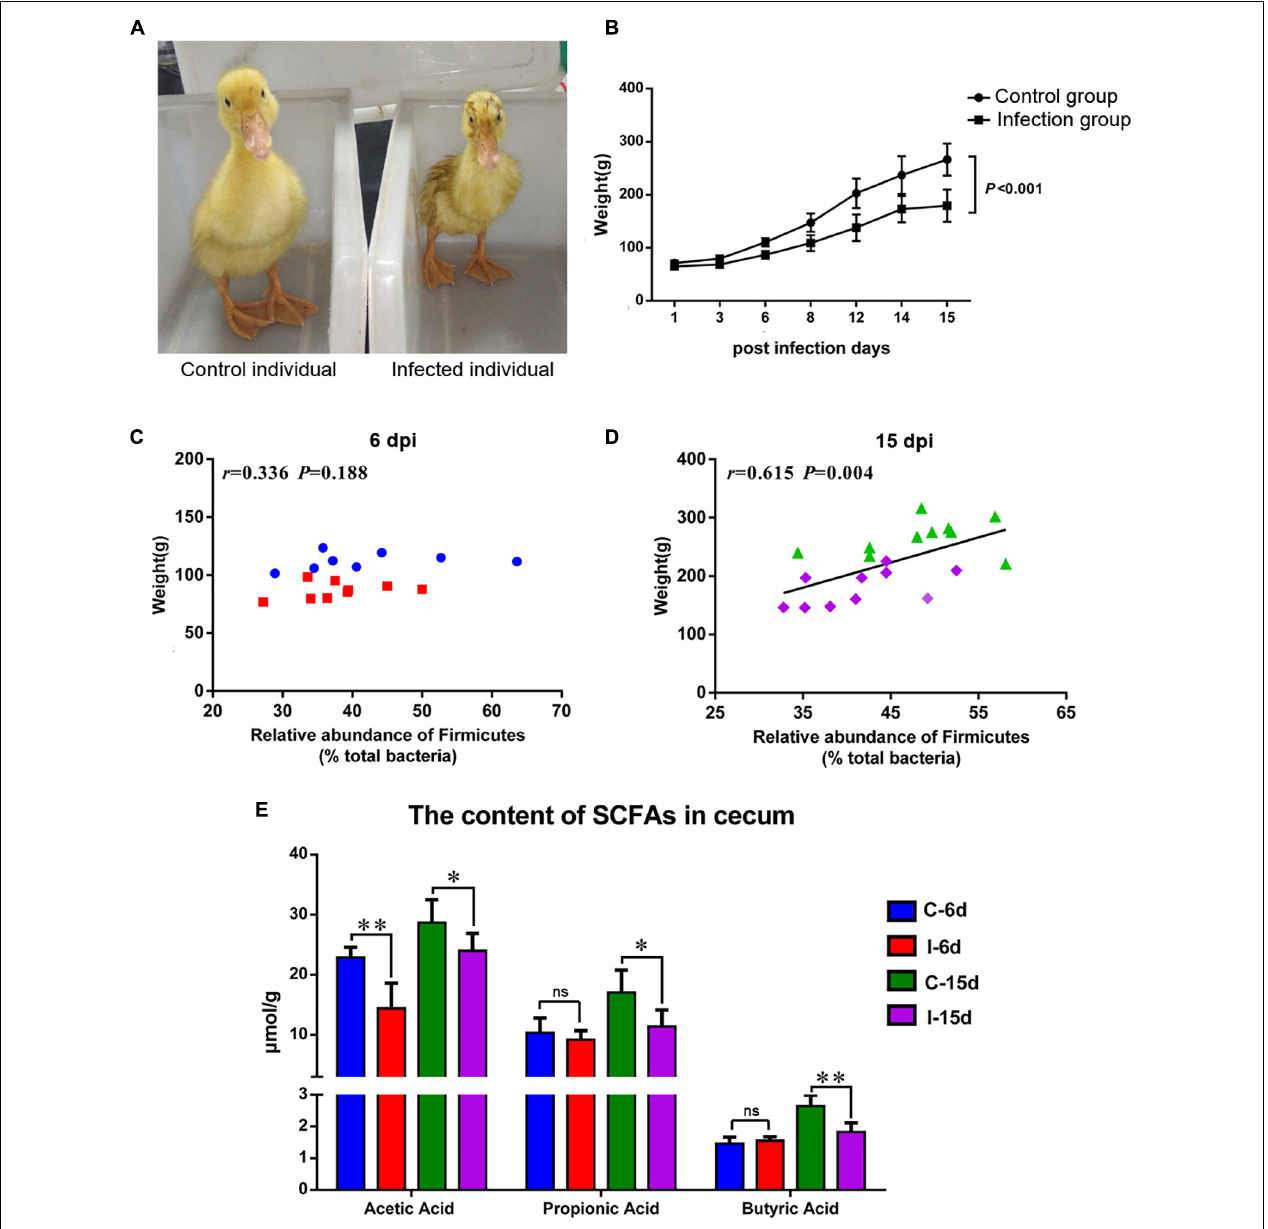
FIGURE 6 | (A) Individual comparison between control duck and infected duck. (B) Body weight of control group and D-GVP infection group ( P < 0.01 by two-tailed Student’s t -test). (C,D) Association between the relative abundance of Firmicutes and body weight of control samples and D-GPV infected samples at 6 dpi and 15 dpi, respectively. Statistical analysis was performed using the Spearman t -test. (E) Effect of D-GPV infection on SCFAs content in caecum. ∗ P < 0.05, ∗∗ P < 0.01 by post hoc ANOVA, and ns meant no significant